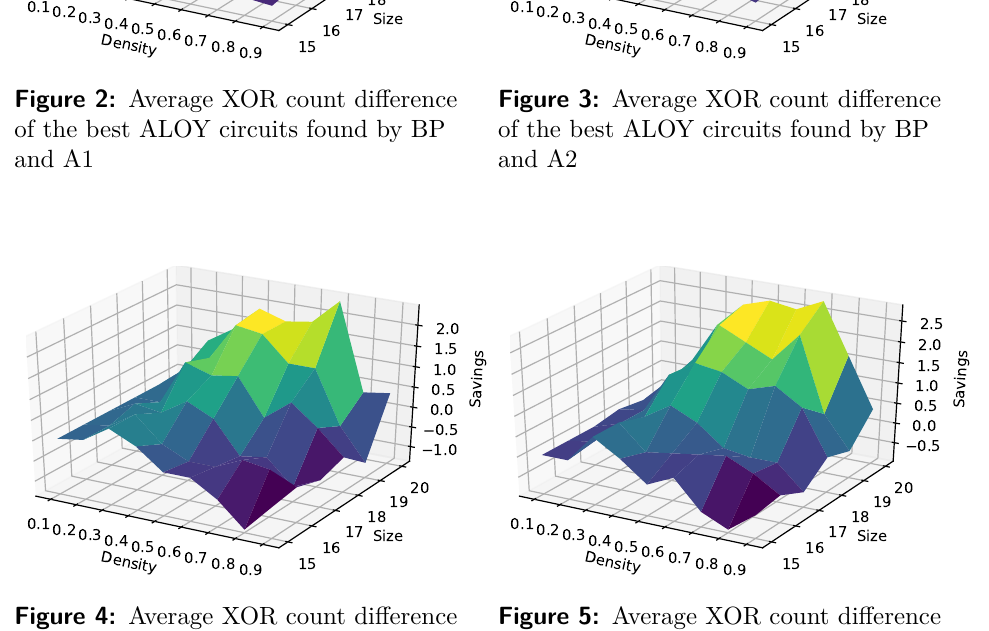
Figure 4: Average XOR count difference of the best ALOY circuits found by RSDF and A1